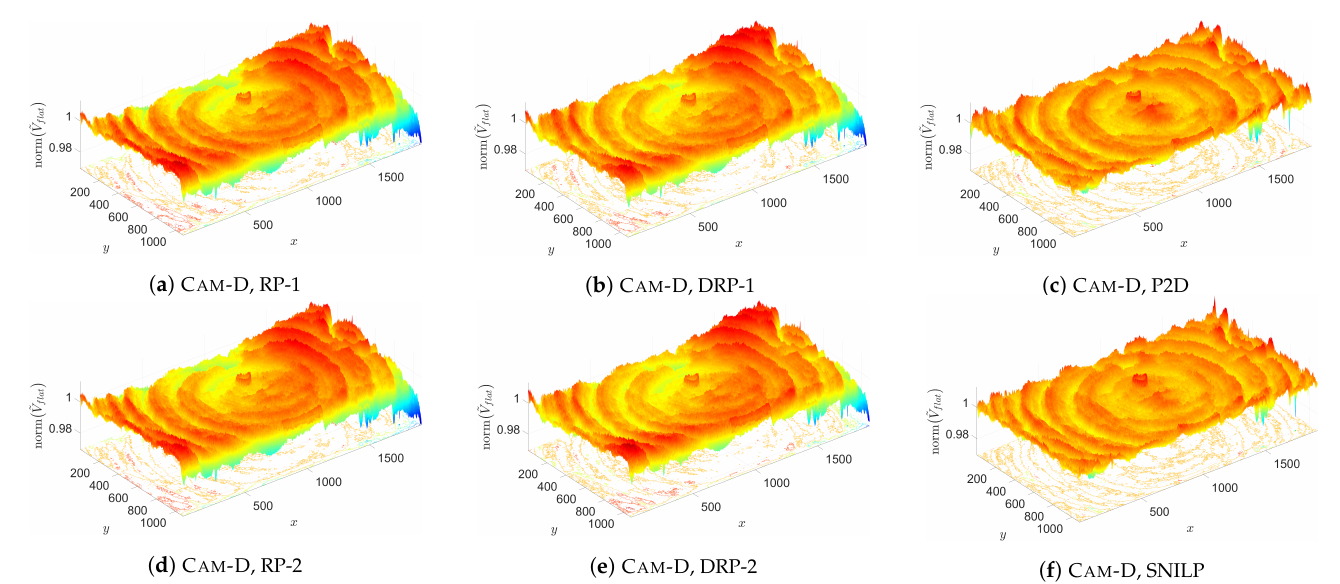
Figure A8. Comparison of vignetting corrections of flat-field image I V for C AM